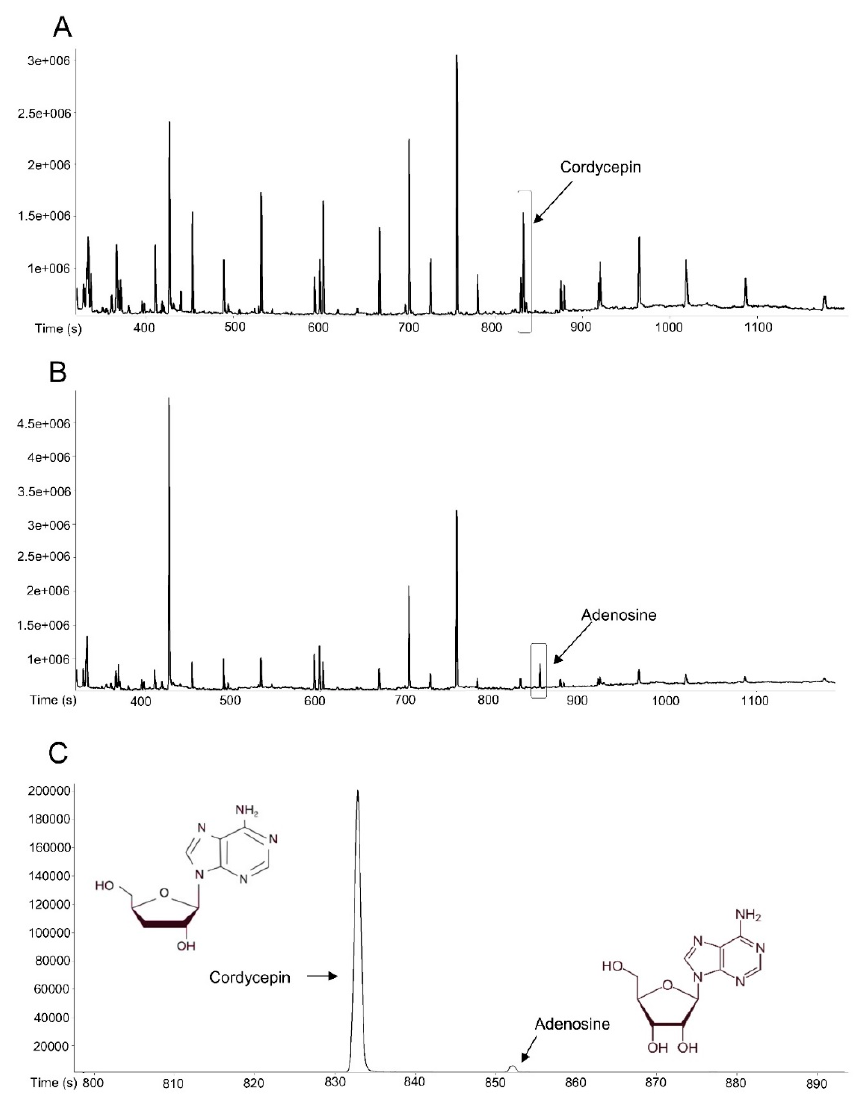
Figure 1. Ion chromatograms of adenosine and cordycepin. GC / MS analysis results of adenosine and cordycepin in ONE (236 m / z) are presented in total ion chromatograms of ( A ) cordycepin and ( B ) adenosine compared to ( C ) extracted ion chromatogram.